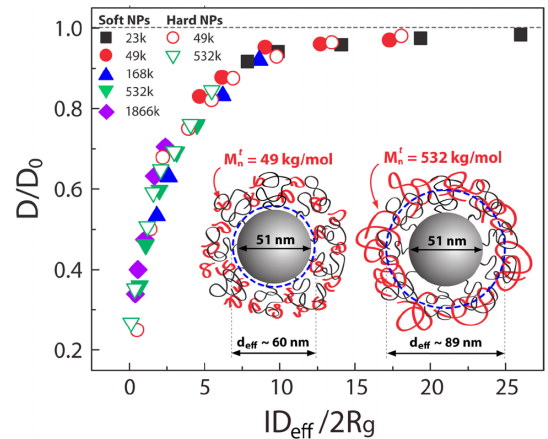
Figure 2. Effect of confinement parameter, defined as the interparticle distance relative to the tracer polymer size, on diffusion. The reduced diffusion coefficient D / D 0 of deuterated PS (dPS) with molecular weights M = 23, 49, 168, 532, and 1866 kDa as a function of the confinement parameter ID eff /2 R g yields a master curve. Closed and open symbols represent dPS diffusion in nanocomposites with soft (SiO 2 –PS87k) and hard (SiO 2 –I) nanoparticles, respectively. [64]. Reprinted from [64] with permission from the American Chemical Society